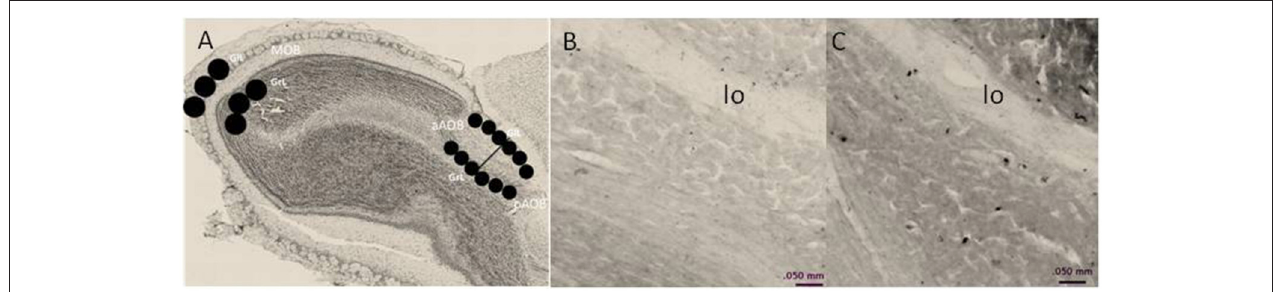
FIGURE 1 | (A) Schematic representation of the regions in which BrdU-positive cells were counted. In the MOB, cells were counted in three, 400- µ m diameter circles placed in the glomerular cell layer (GlL) and granular cell layer (GrL). The AOB was divided into the anterior (aAOB) and posterior (pAOB) regions, and cells were counted in the three 200- µ m circles were placed in the GlL and GrL. (B,C) are representative photomicrographs (10X) of the BrdU-positive cells in the GrL of the pAOB in (B) control and (C) three ejaculation groups. lo lateral olfactory tract.